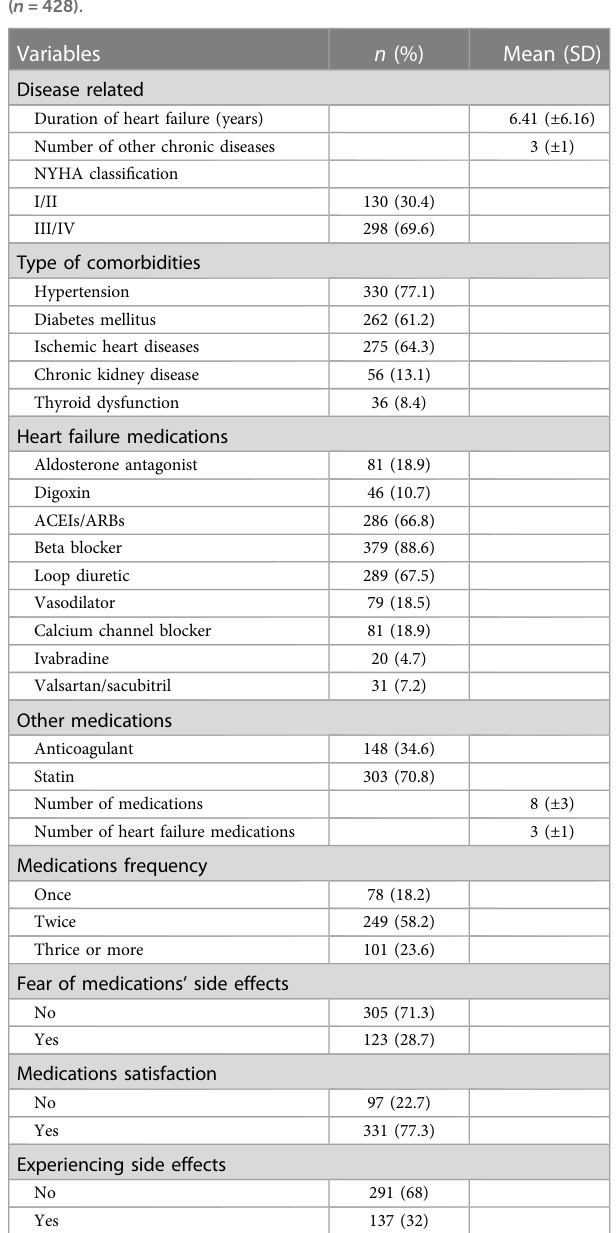
TABLE 3 Laboratory tests of the study participants ( n =428).